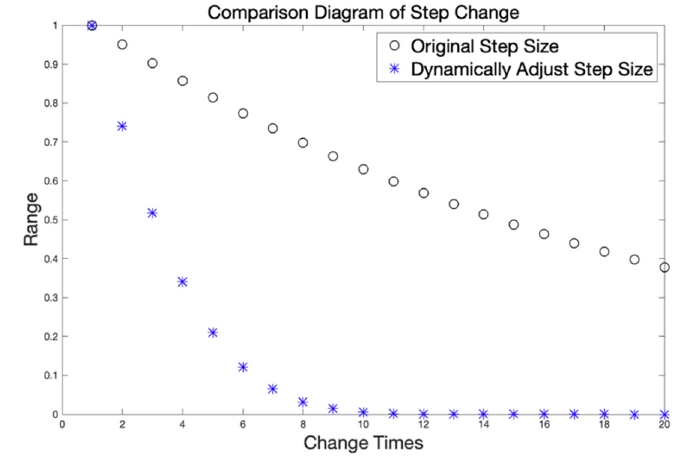
Figure 6. Comparison diagram of step decreasing.